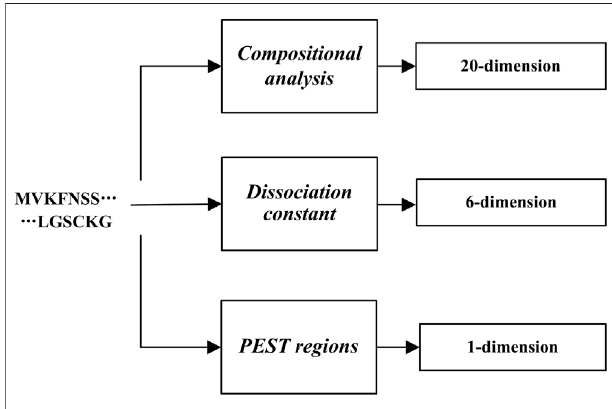
FIGURE 1 | Flow chart of Feature